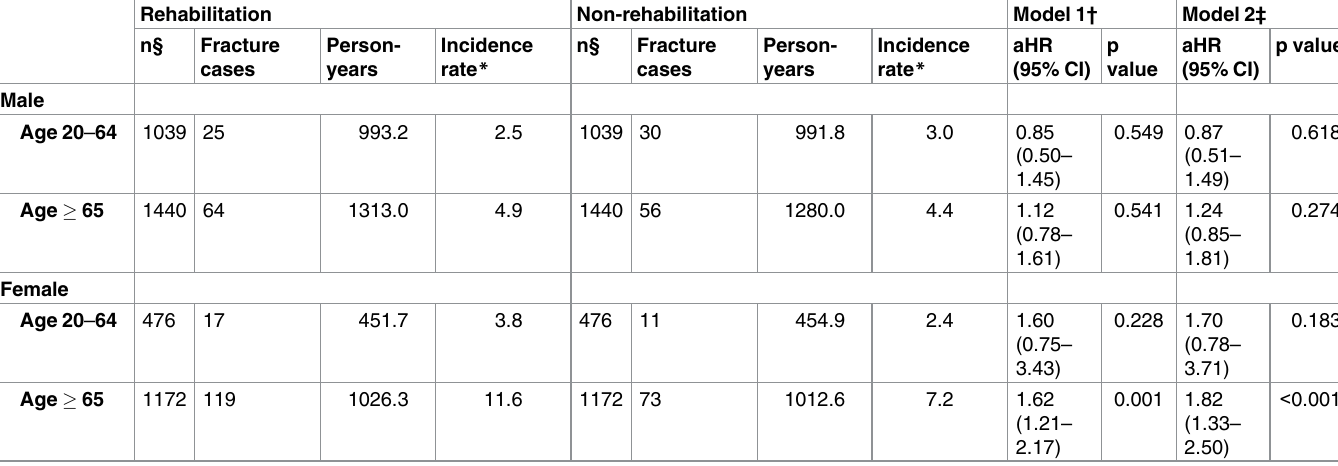
Table 4. Risk of fracturesfor patients with and without post-stroke rehabilitation stratified by sex and age.